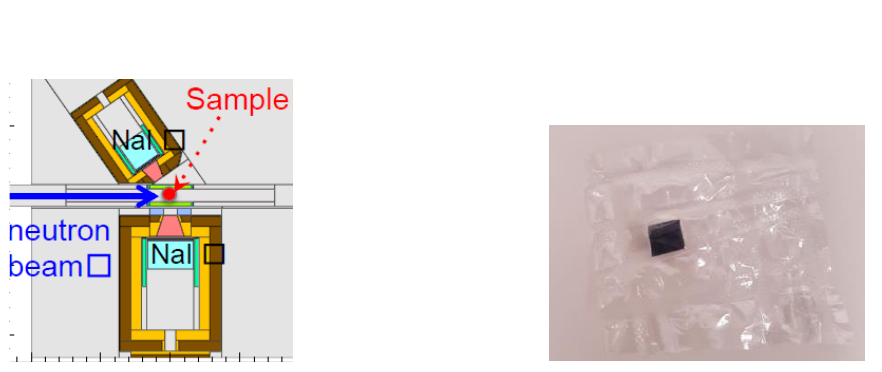
Figure 2. NaI detector in ANNRI (left) and 0.1 mm Mo sample in the FEP film (right)